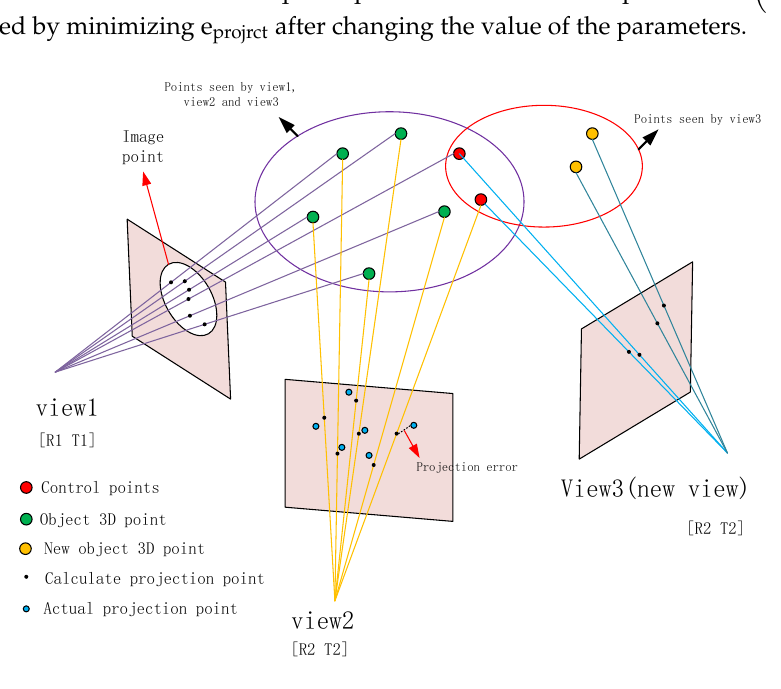
Figure 5. Weighted bundle adjustment.